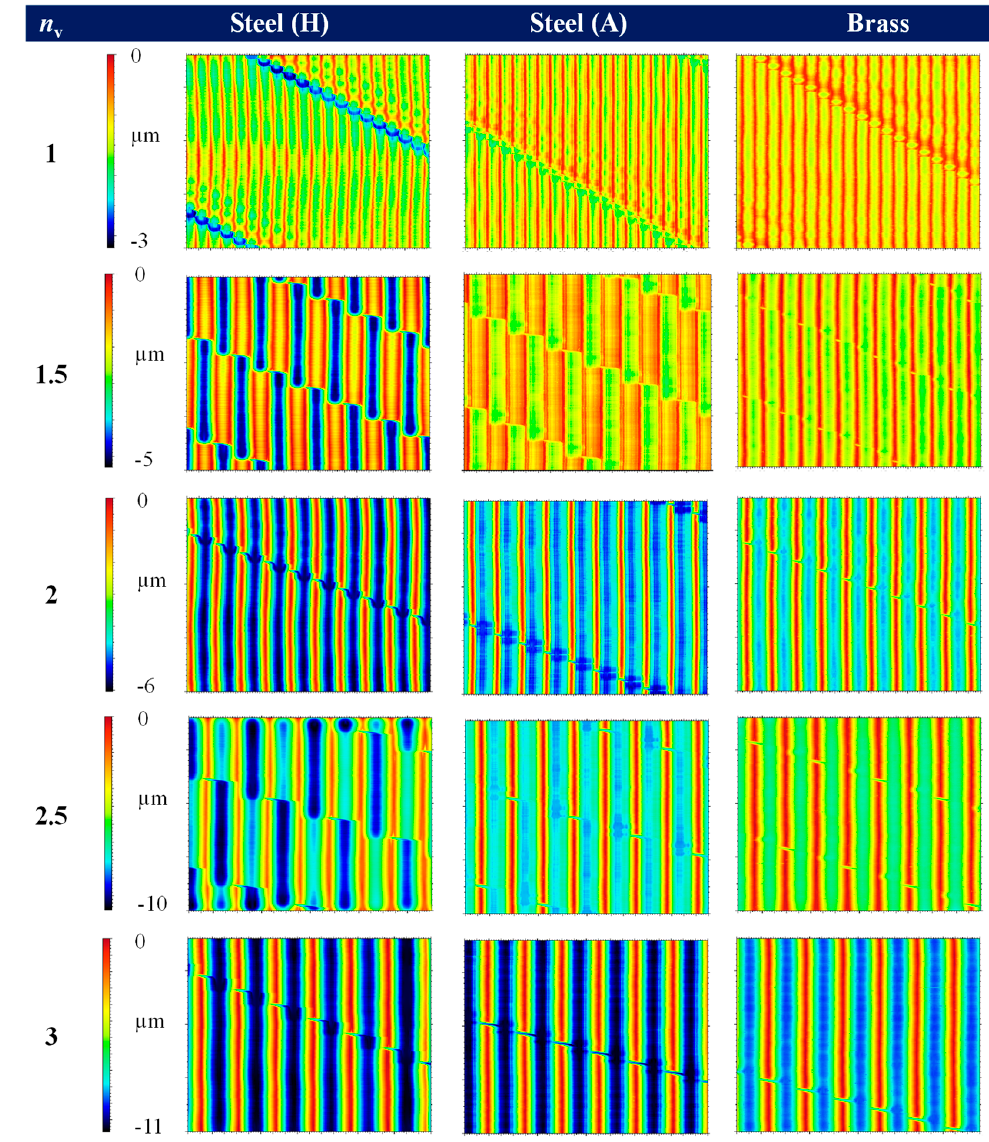
Figure 5. Overview of the twist-free surfaces created by SST; each field is 1.8 mm in width and 360° in length.